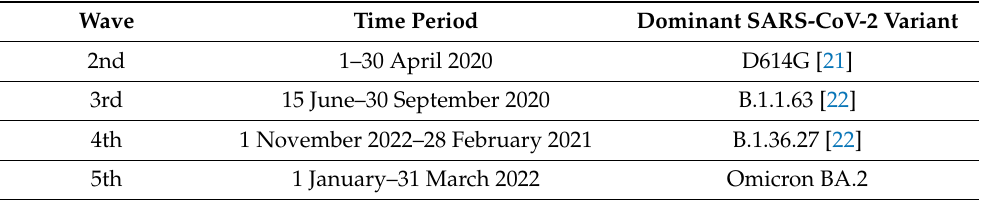
Table 2. Time period and dominant SARS-CoV-2 variant during each local breakthrough wave during